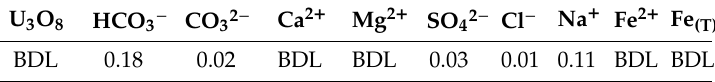
Table 3. Chemical composition of laboratory tap water (g /